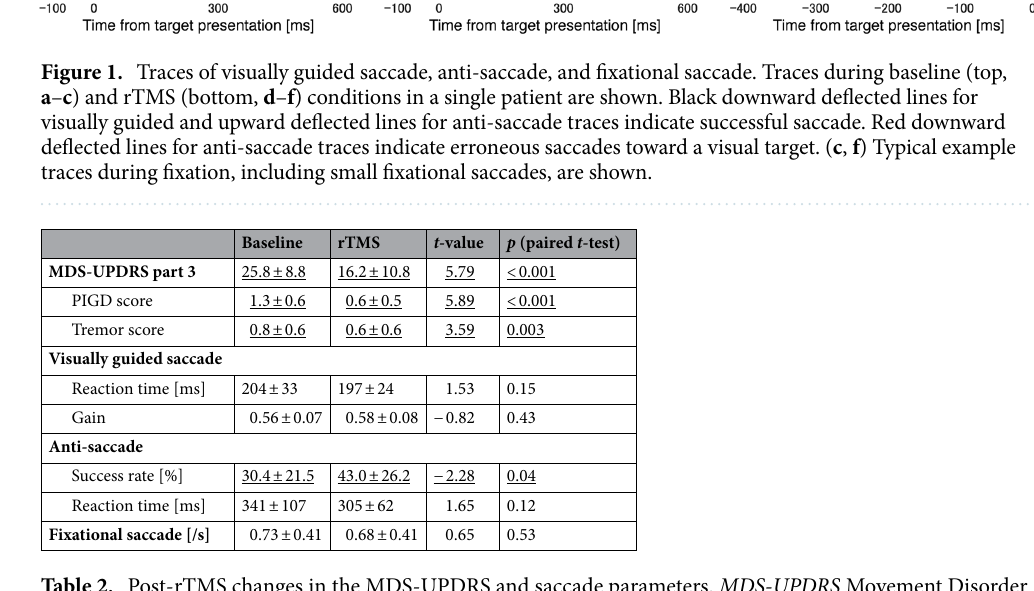
Table 2. Post-rTMS changes in the MDS-UPDRS and saccade parameters. MDS-UPDRS Movement Disorder Society-Sponsored Unified Parkinson’s Disease Rating Scale, PIGD postural instability gait difficulty, rTMS repetitive transcranial magnetic stimulation. Statistically significant rTMS effects are underlined ( p <